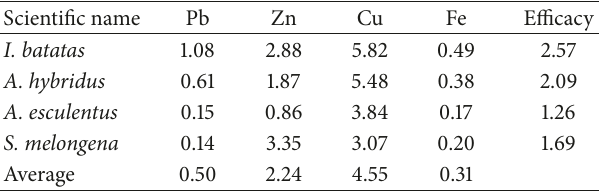
Table 4: Soil-vegetable transfer coefficients (%) of heavy metals.